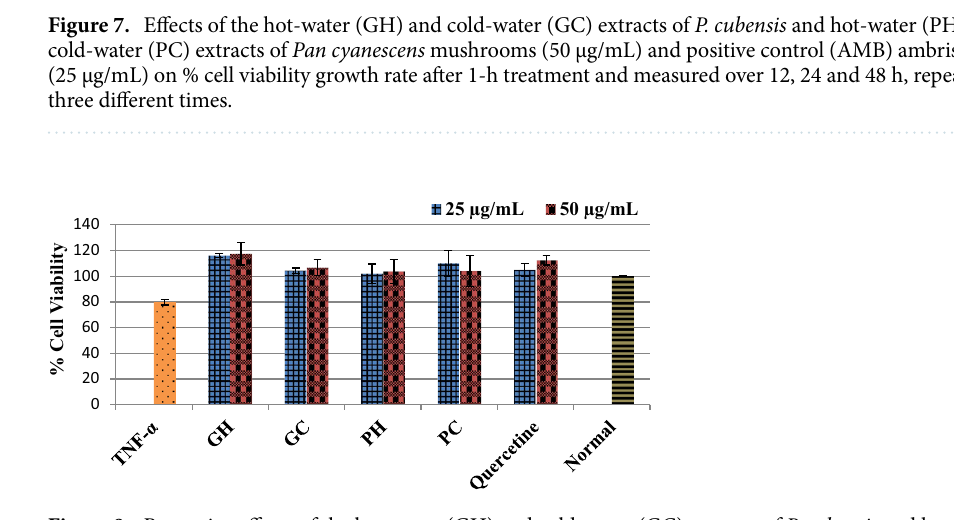
Figure 8. Protective effects of the hot-water (GH) and cold-water (GC) extracts of P. cubensis and hot-water (PH) and cold-water (PC) extracts of Pan cyanescens mushrooms (25 and 50 µg/mL) and the positive control quercetin (12.5 and 25 µg/mL) on TNF-α-induced cell injury and cardiomyocytes death over 24 h, repeated in three different times